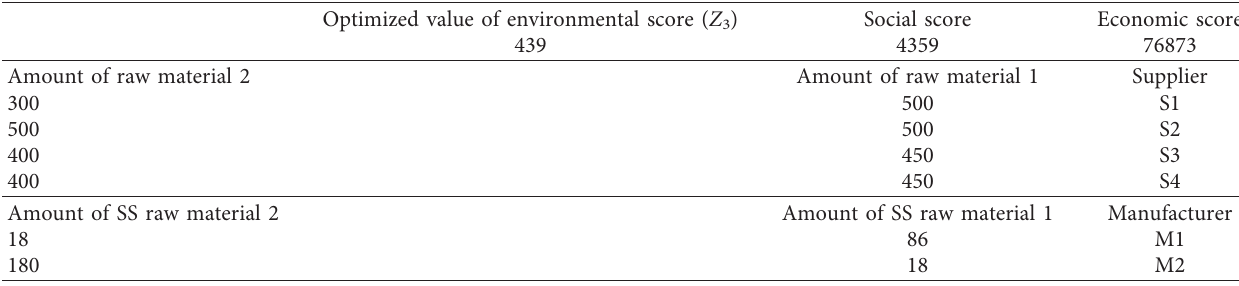
Table 7: Value of objective functions and supply portfolio by optimizing Z